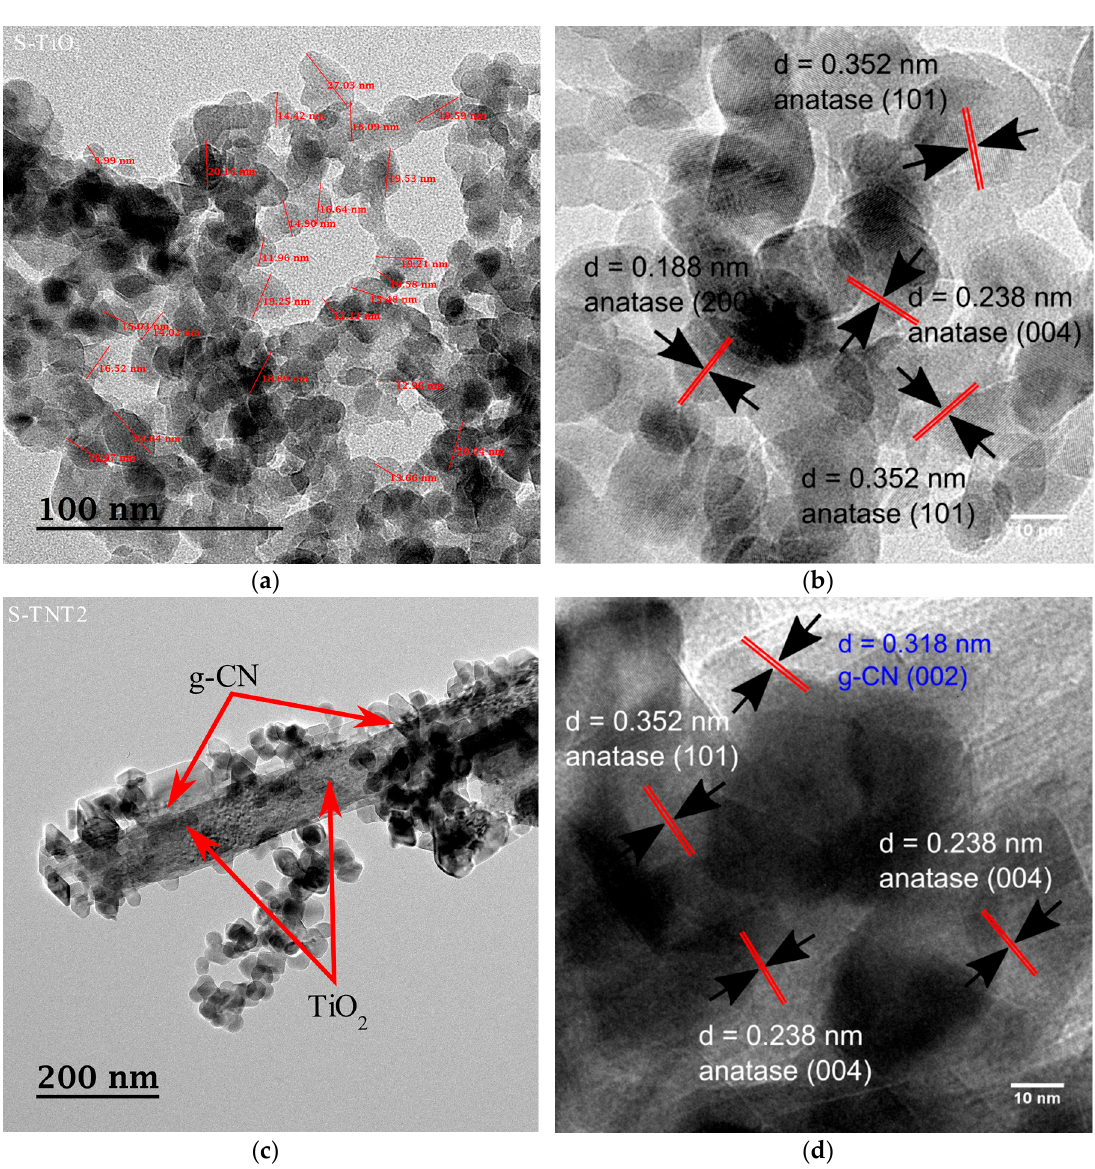
Figure 3. Transmission electron microscopy (TEM) images of the as-prepared S-TiO 2 ( a )–( b ) and S- TNT2 ( c )–( d